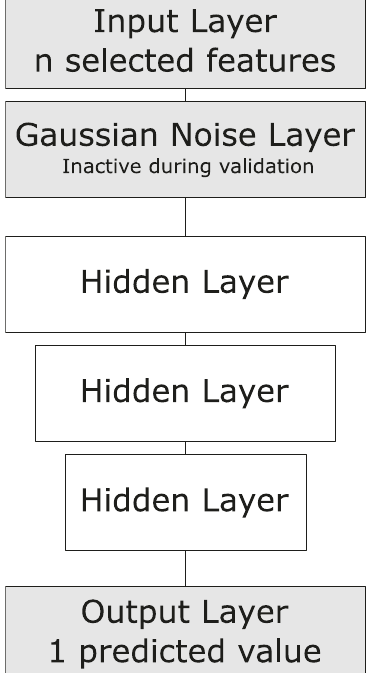
Fig. 5 Example architecture for deep learning models. General architecture of a deep learning model used for predicting corrosion inhibition ef fi ciencies of chemical compounds (output) from molecular features (input).